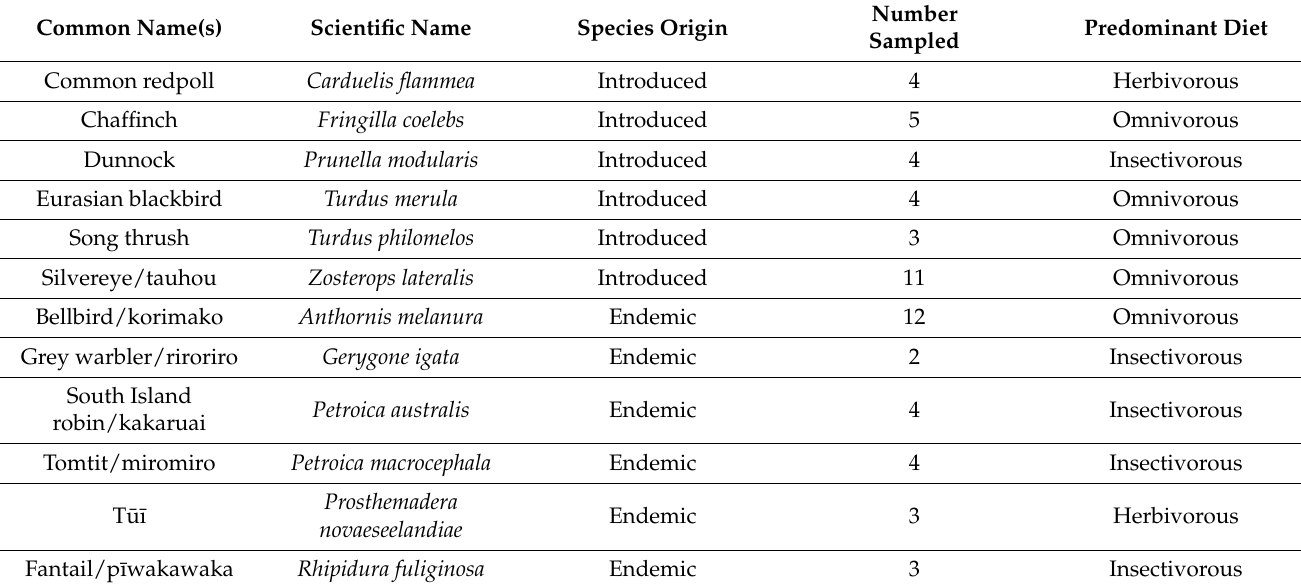
Table 1. Summary of species sampled, including the common and Latin names, the origin of the species in New Zealand, the number of individual birds sampled, and the predominant diet of each species. Endemic = evolved in New Zealand, Introduced = evolved elsewhere and established in New Zealand via either deliberate human introduction or natural